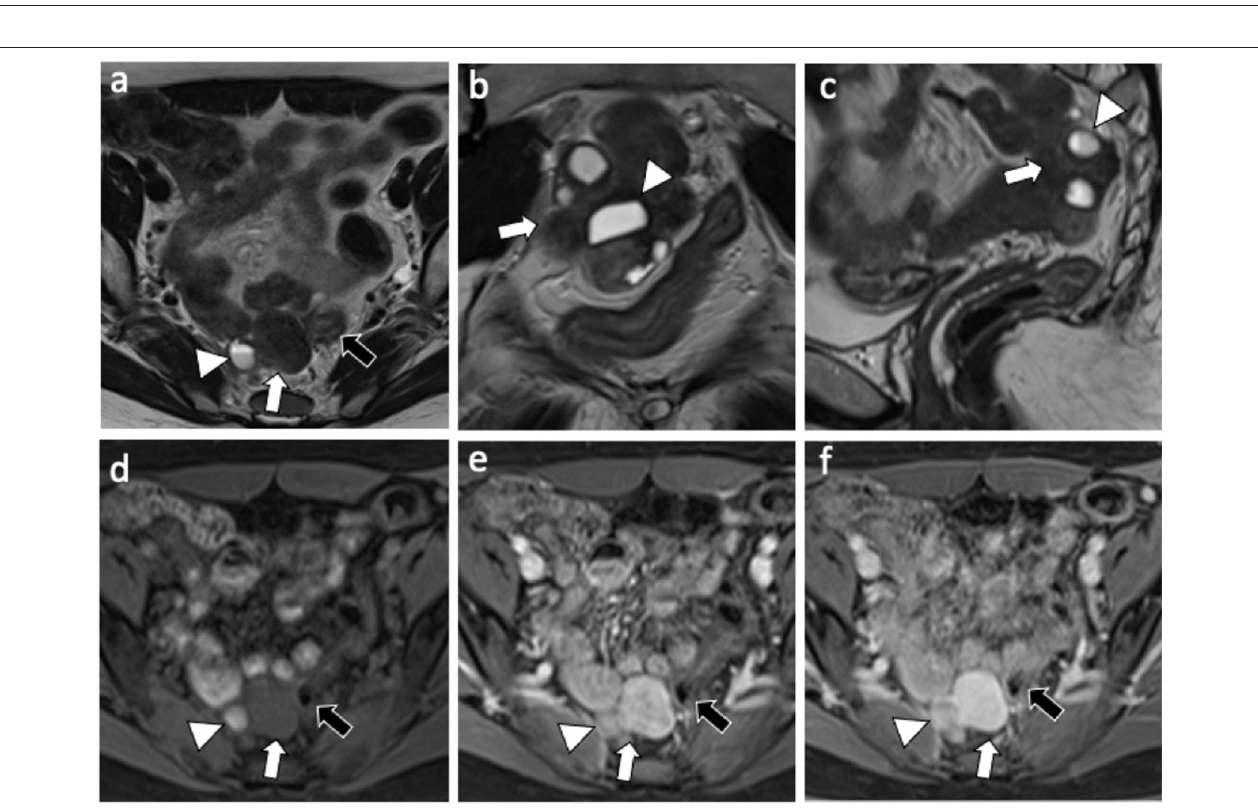
FIGURE 2 | MRI exam: Axial (a) coronal (b) and sagittal (c) T2-weighted images shows a 6cm × 4cm multilobed mass (white arrow) characterized by both solid and cystic component (white arrowhead) with fluid-fluid level (hemorragic); axial T1-weighted fat-suppressed pre-contrast (d) , and arterial (e) and delayed (f) post-contrast phase shows omogeneous enhancement of the mass with no clivage plane toward the sigmoid wall (black arrow).